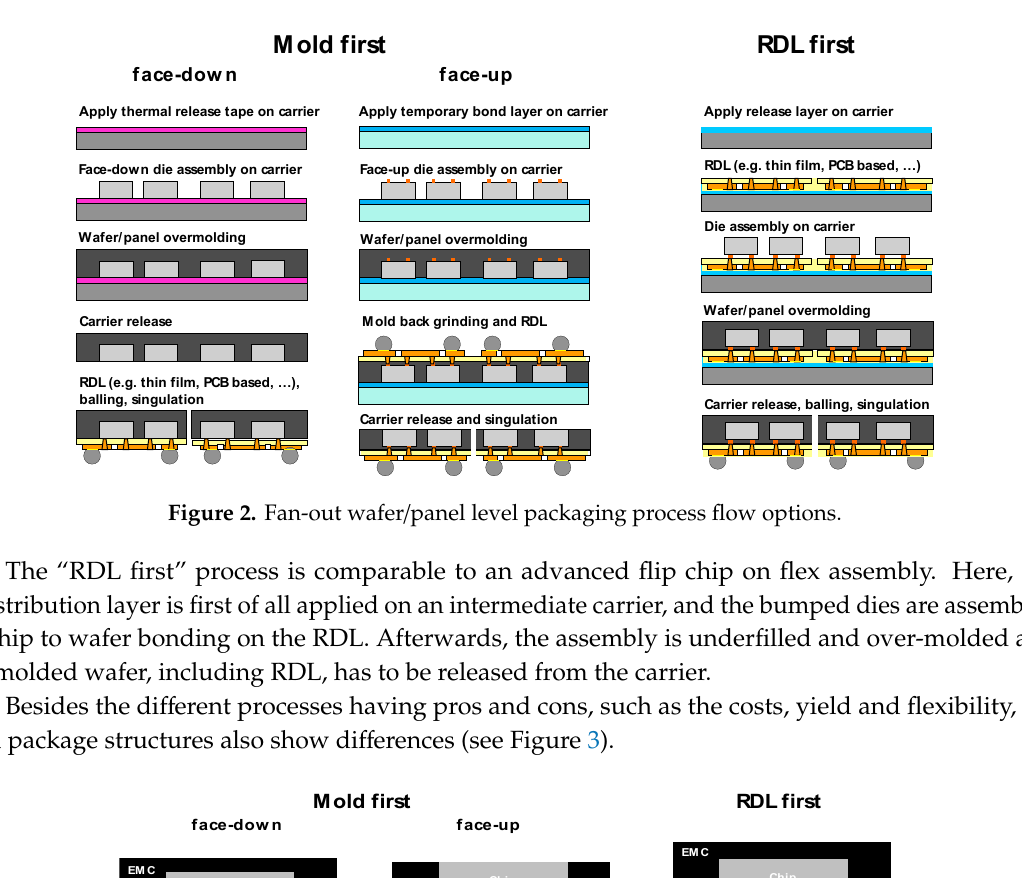
Figure 2. Fan-out wafer/panel level packaging process flow options.